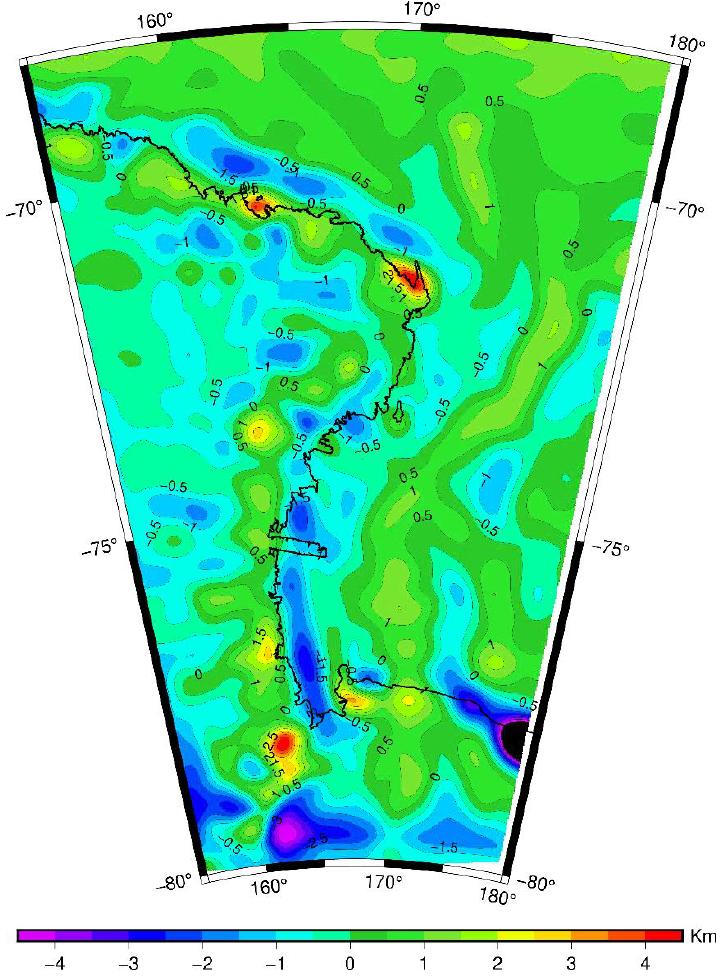
Figure 6. Difference between two Moho depth estimates assuming 30 km and 50 km for the reference height of the gravity disturbance upward continuation.